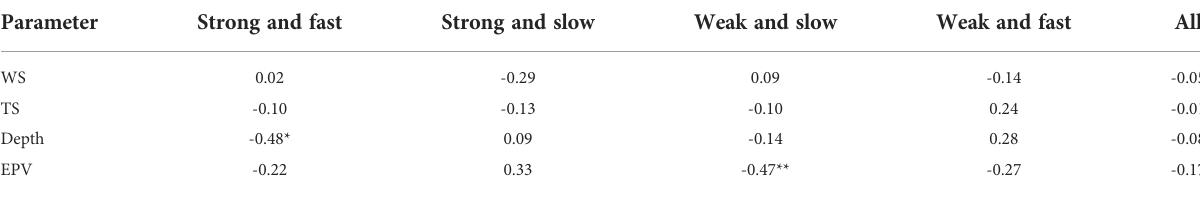
TABLE 4 The Partial correlation coef fi cients between the Chl_en and TC wind speed (WS), translation speed (TS), water depth and Ekman pumping velocity (EPV) in the continental shelf region. Parameter Strong and fast